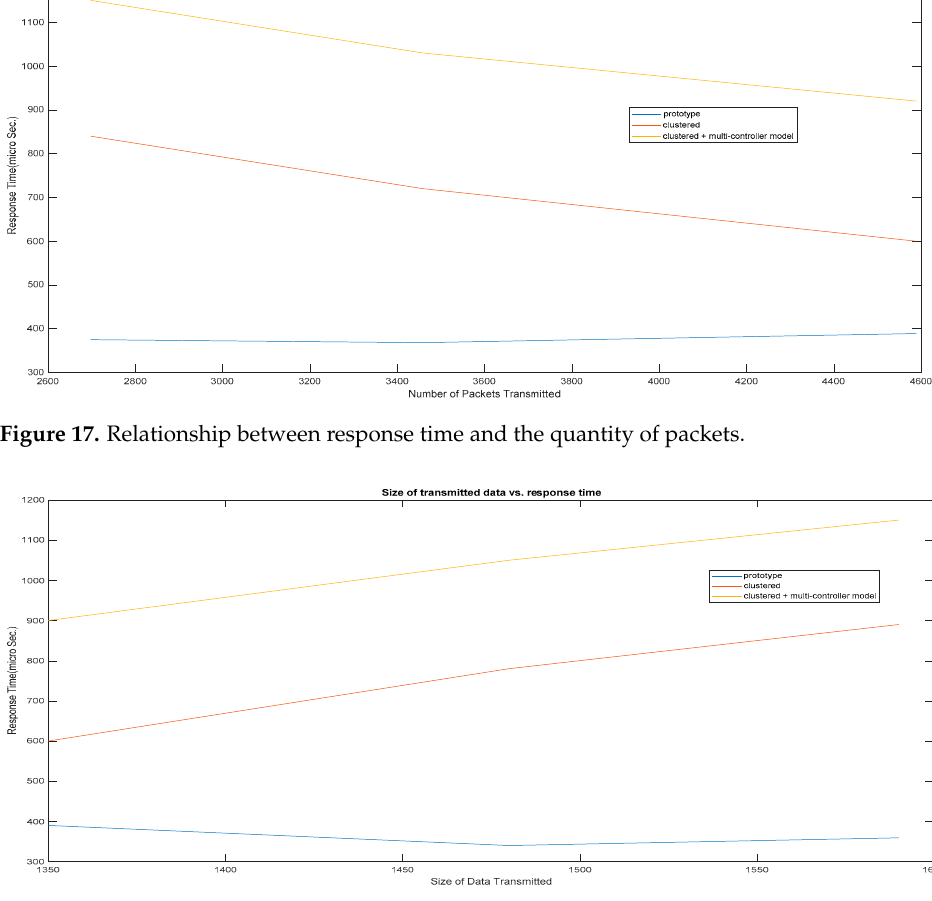
Figure 18. Size of transmitted data vs. response time.